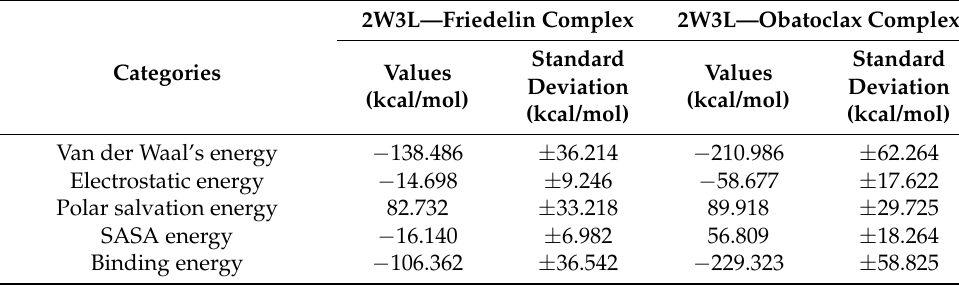
Table 2. Binding free energy calculation of 2W3L target protein complexed with Friedelin and